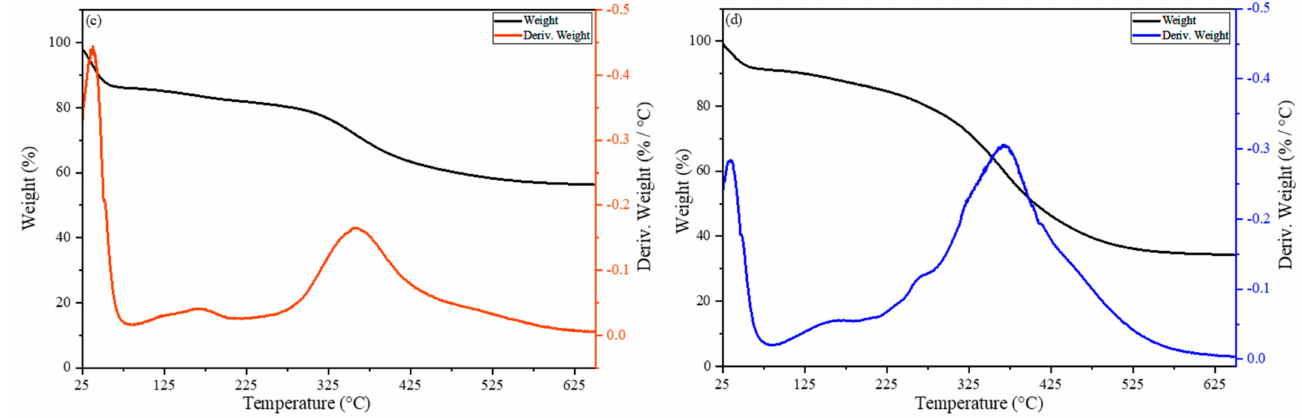
Figure 3. Thermogravimetric (TG) and differential thermogravimetric (DTG) profiles of ( a ) NWS, ( b ) NCS, ( c ) MWS, and ( d ) MCS samples.